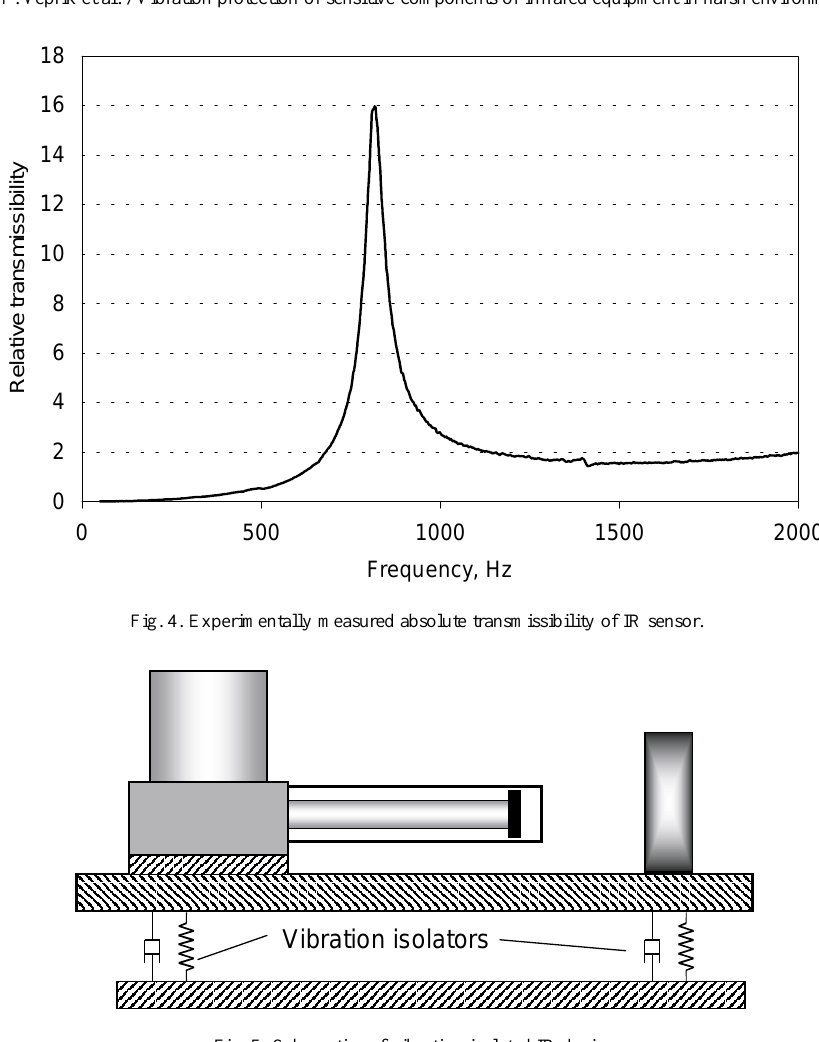
Fig. 5. Schematics of vibration isolated IR